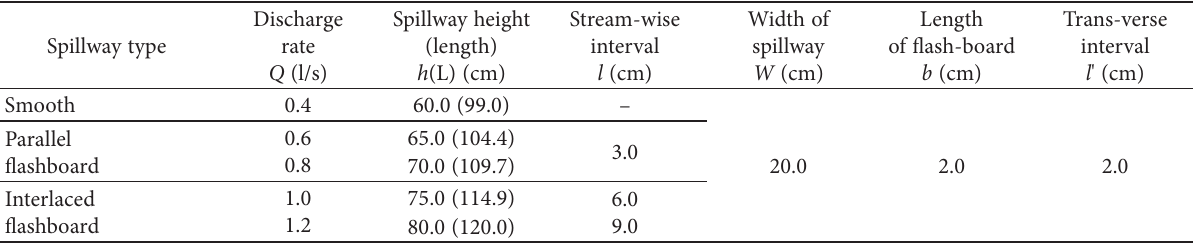
Table 1. Combinations of test conditions